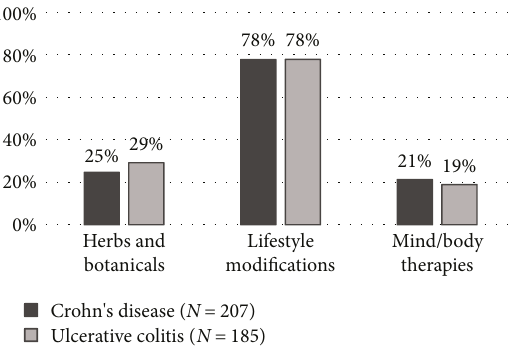
Figure 5: Frequency of CAM use among IBD patients. CAM: complementary and alternative medicine; IBD: in fl ammatory bowel